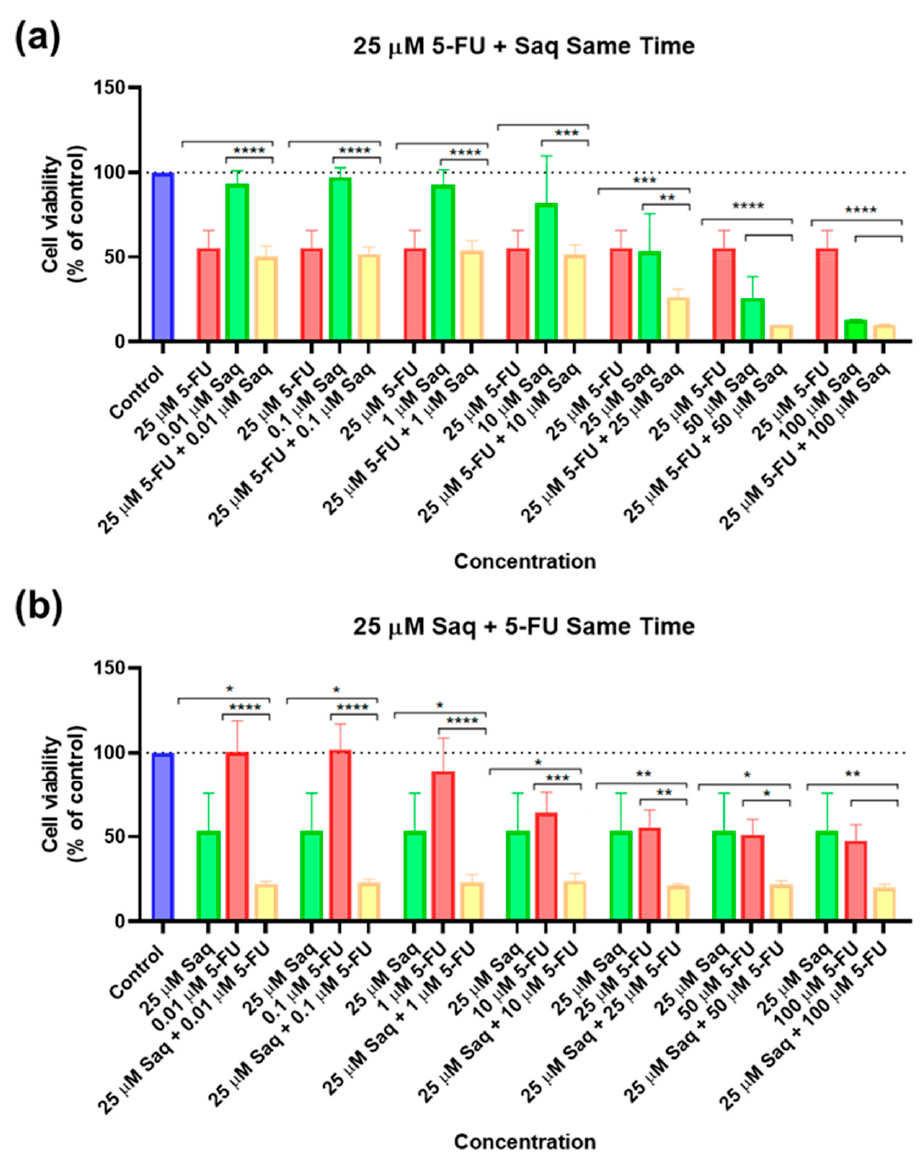
Figure 7. Cytotoxic results of PC-3 after exposure to drug combinations at the same time for 48 h. ( a ) Combination of 25 µ M of 5-FU with increasing concentrations of saquinavir (0.01–100 µ M); ( b ) combination of 25 µ M of saquinavir with increasing concentrations of 5-FU (0.01–100 µ M). Control cells were treated with 0.01% DMSO (vehicle). Cell viability was obtained using the MTT assay and the results are given as the mean ± SEM ( n = 3). * Statistically significant vs. drug alone at p < 0.05; ** statistically significant vs. drug alone at p < 0.01; *** statistically significant vs. drug alone at p < 0.001; **** statistically significant vs. drug alone at p < 0.0001.